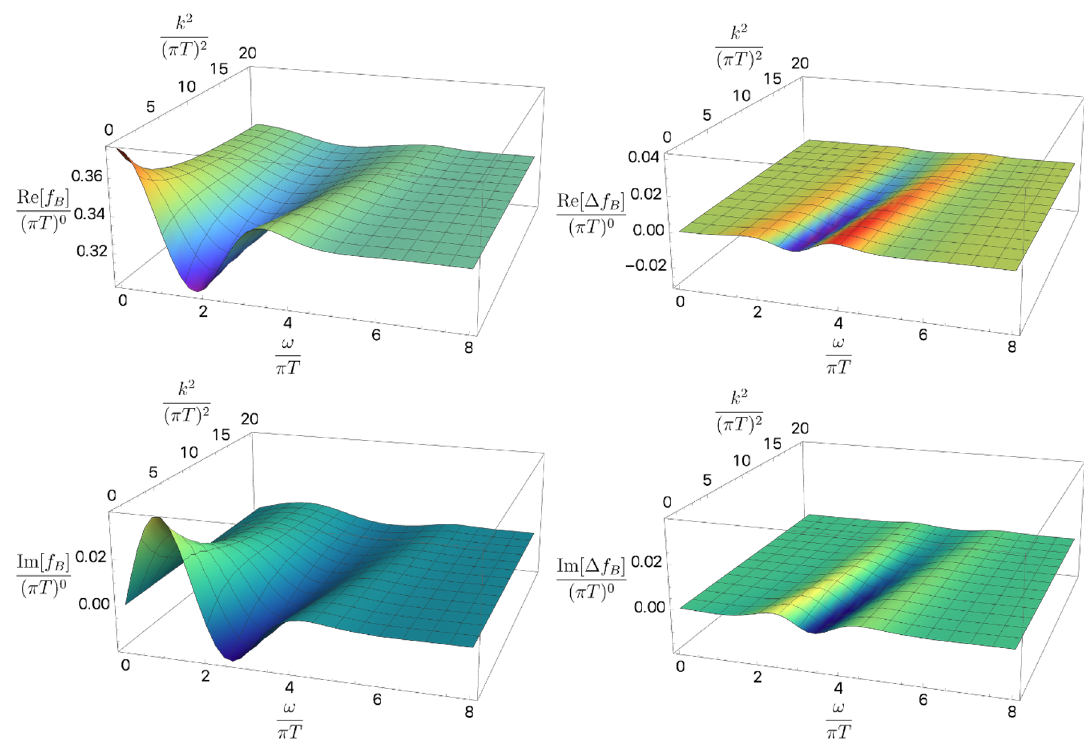
Figure 4 . Left column: real and imaginary parts for the B component of the all order drag force as functions of ! and k 2 , evaluated with the spectral method. Right column: the resulting di(cid:11)erences between the B components as evaluated through the spectral and matching